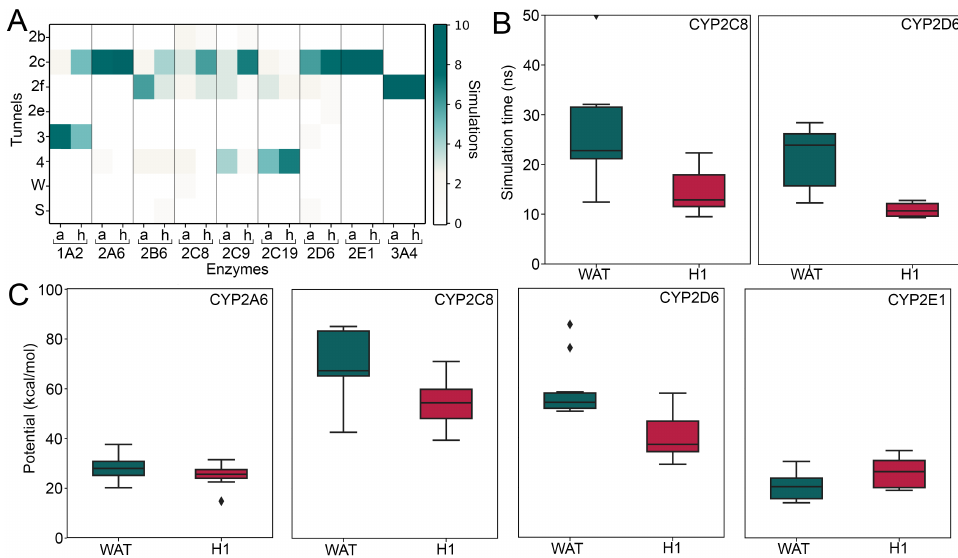
Figure 3. Results from metadynamics simulations. ( A ) Heat map of selected pathways with (h) and without (a) allosteric ligand. ( B ) Boxplots of simulation times ( ∆ T) until the ligand completely dissociated from the active site. ( C ) Boxplots of maximal potential (P max ) registered until the ligand completely dissociated from the active site. (cid:7) : allosteric